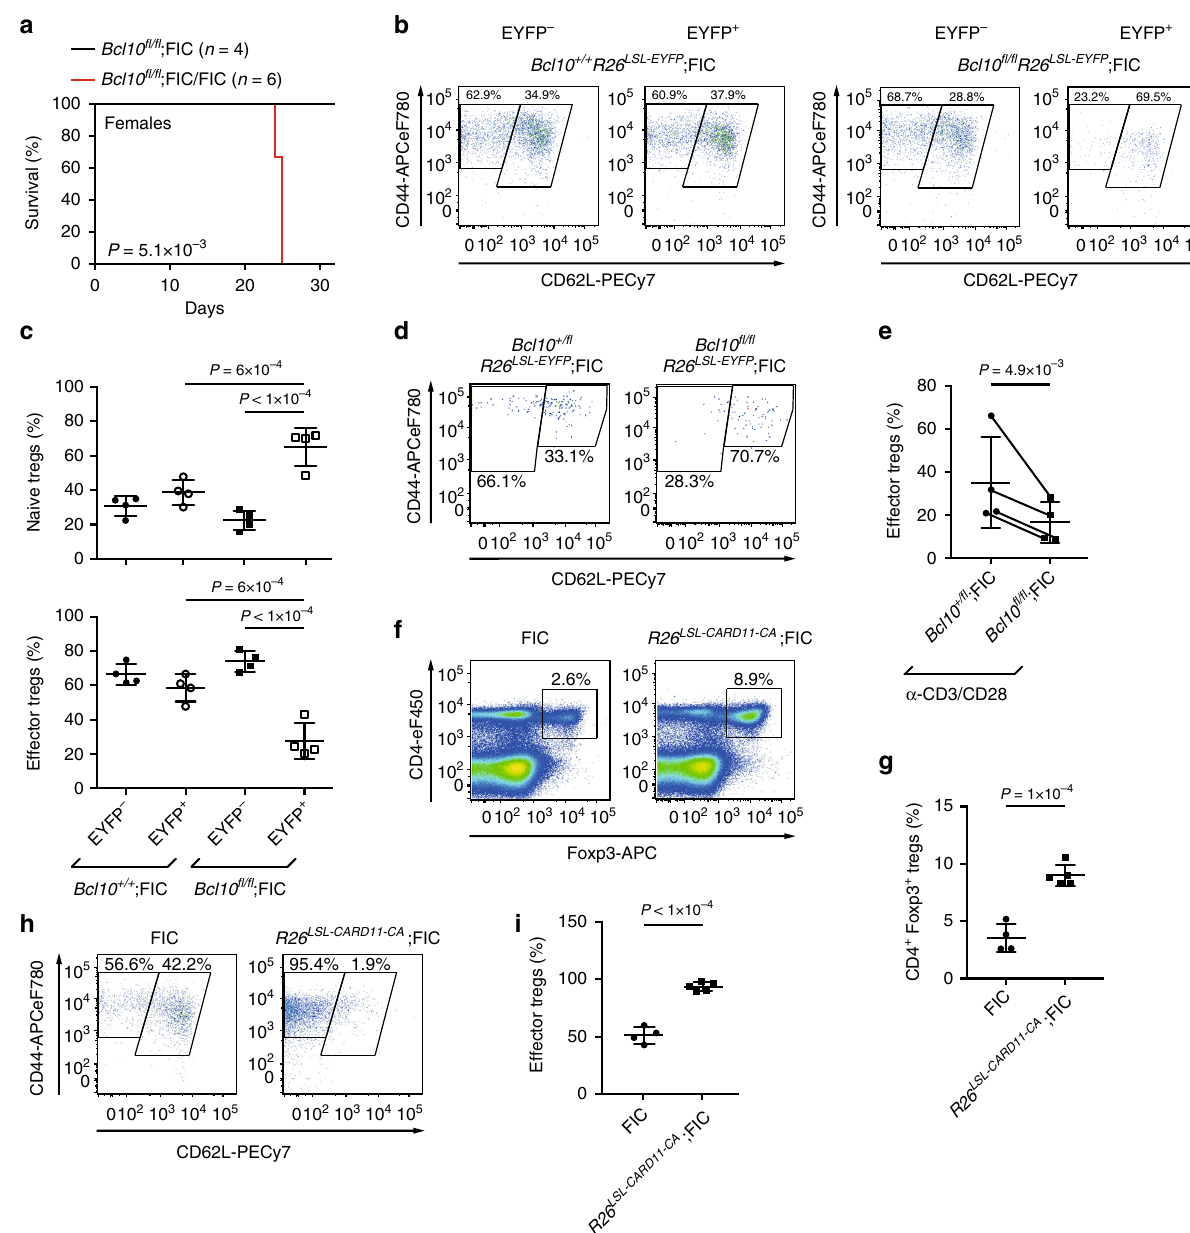
Fig. 2 BCL10 signaling controls the homeostatic resting regulatory T cell (rTreg) to effector Treg (eTreg) conversion. a Survival curves of Bcl10 fl / fl ;FIC (black line, n = 4) versus Bcl10 fl / fl ;FIC/FIC female mice (red line, n = 6). P value was calculated by a log-rank (Mantel – Cox) test. b Fluorescence-activated cell sorting (FACS) pro fi les to detect either EYFP – (left) or EYFP + (right) CD62L hi naive rTregs and CD44 hi CD62L lo eTregs in the viable CD4 + Foxp3 + splenic Treg population of Bcl10 + / + Rosa26 LSL-EYFP ;FIC (left plots) and Bcl10 fl / fl Rosa26 LSL-EYFP ;FIC (right plots) female mice. Plots are representative of four mice each. c Frequencies of splenic EYFP – - and EYFP + -gated CD62L hi naive rTregs (upper panel) and CD44 hi CD62L lo eTregs (lower panel) in the viable CD4 + way analysis of variance (ANOVA) combined with Tukey ’ s multiple comparisons test. d Representative FACS experiment to detect the differentiation of sorted splenic CD4 + EYFP + CD62L hi naive rTregs of ≥ 2 pooled female Bcl10 fl / fl ; Rosa26 LSL-EYFP ;FIC and Bcl10 + / fl ; Rosa26 LSL-EYFP ;FIC control mice into CD4 + EYFP + CD44 hi CD62L lo eTregs following 3 days of stimulation with anti-CD3/CD28. e Quanti fi ed percentages of differentiated eTregs. Data are from four independent experiments with ≥ 2 pooled mice per genotype. To avoid prominent effects of single data points on the mean, statistical signi fi cance was assessed by a two-tailed ratio-paired t test with corresponding paired data points of one experiment connected by a line. f FACS analysis to detect viable splenic CD4 + Foxp3 + Tregs in 12-week-old FIC ( n = 4) or Rosa26 LSL-CARD11-CA ;FIC female mice ( n = 5). g Frequency of viable splenic CD4 + Foxp3 + Tregs in 12-week-old FIC or Rosa26 LSL-CARD11-CA ;FIC female mice. h Representative FACS pro fi le detecting the percentages of CD62L hi rTregs and CD44 hi CD62L lo eTregs within the viable CD4 + Foxp3 + splenic Treg population of 12-week-old FIC ( n = 4) or Rosa26 LSL-CARD11-CA ;FIC ( n = 5) female mice. i Frequencies of viable splenic CD44 hi CD62L lo eTregs in FIC control or Rosa26 LSL-CARD11-CA ;FIC female mice. To detect the transgene in h , i , gating was performed on CD4 + Foxp3 + GFP + cells. Statistical signi fi cances in g , i were assessed by a two-tailed unpaired Student ’ s t test. Bars in c , e , g , i represent the mean ± SD. Data in c are representative of three independent experiments, while data in f – i are cumulative from two independent experiments. Source data are provided as a Source Data File NATURE COMMUNICATIONS| (2019) 10:2352 |https://doi.org/10.1038/s41467-019-10203-2|www.nature.com/naturecommunications